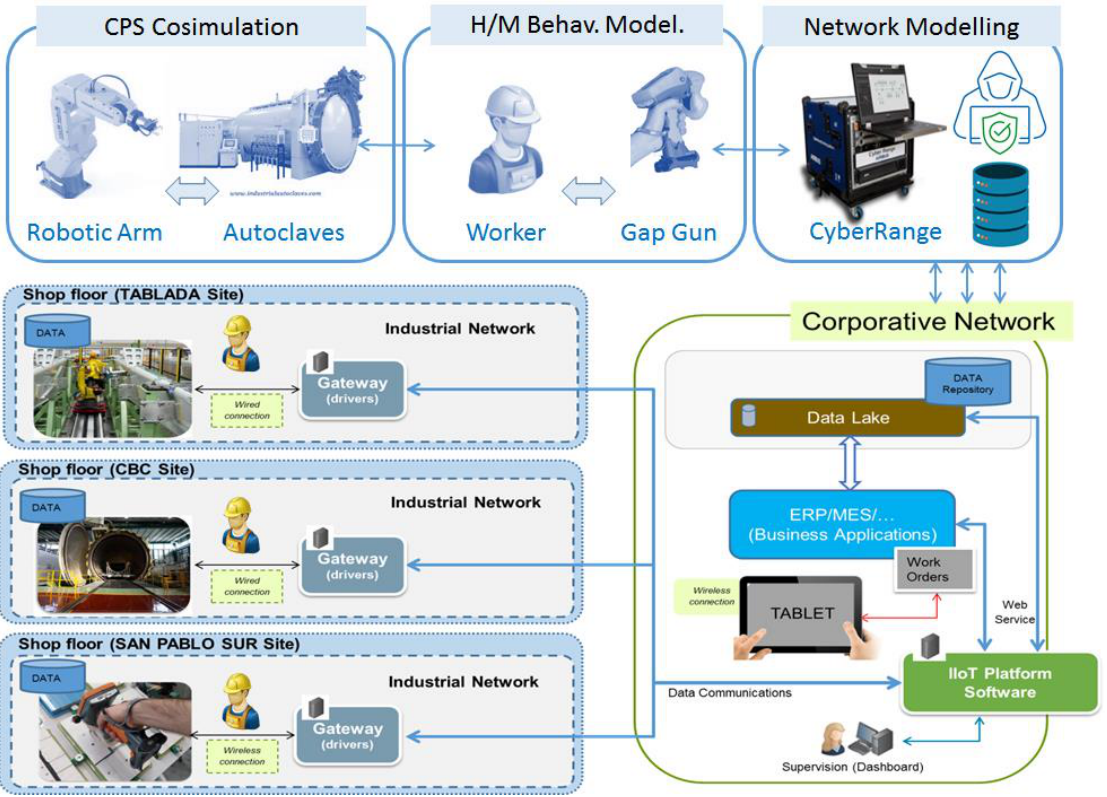
Figure 7. Architecture Aerospace Manufacturing Use-Case.